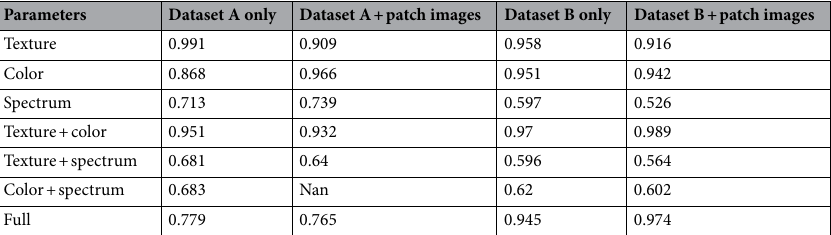
Table 6. Classification results of a DNN model according to dataset types. It shows the F1-score of the performance of a DNN model. We trained the classifier using combinations of features extracted from the new dataset (including patch images) or the initial dataset and can identified the difference of classification performance of a DNN model.